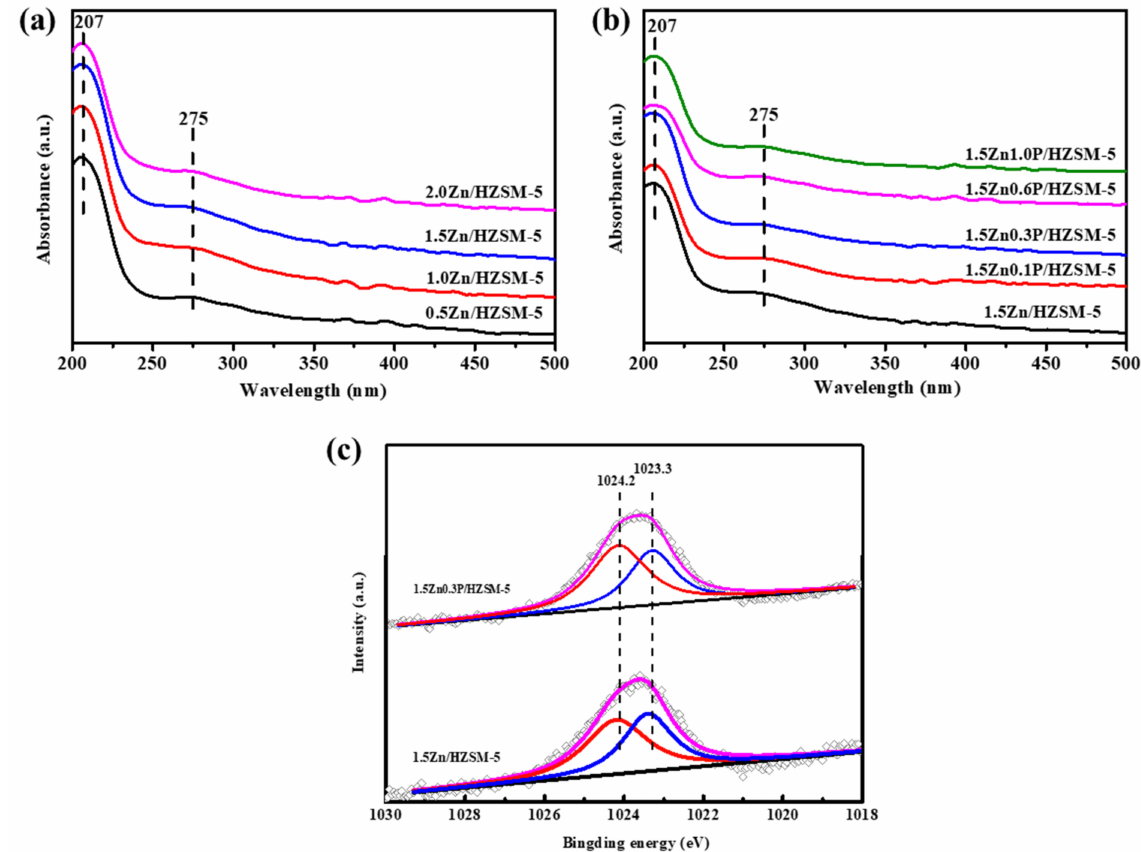
Figure 5. Ultraviolet–visible (UV-vis) spectra of Zn modified ( a ) and Zn-P co-modified ( b ) samples and X-ray photoelectron spectroscopy (XPS) spectra of Zn 2P 3/2 for 1.5Zn/HZSM-5 and 1.5Zn0.3P/HZSM-5 ( c